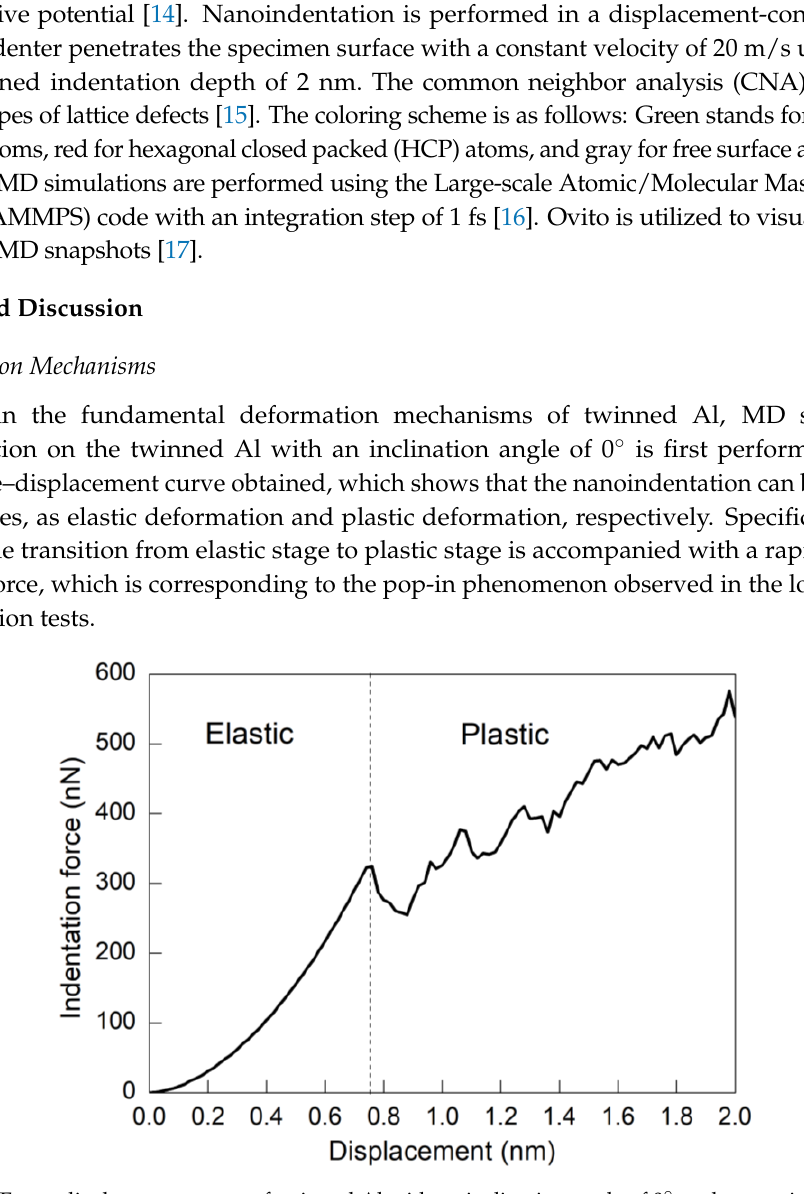
Figure 1. Atomic structures of nanotwinned Al containing differently inclined twin boundaries (TBs). Inclined angle of TBs: ( a ) 0°; ( b ) 26°; ( c ) 45°; ( d ) 64°; and ( e ) 90°. Atoms are colored according to their common neighbor analysis (CNA) values.